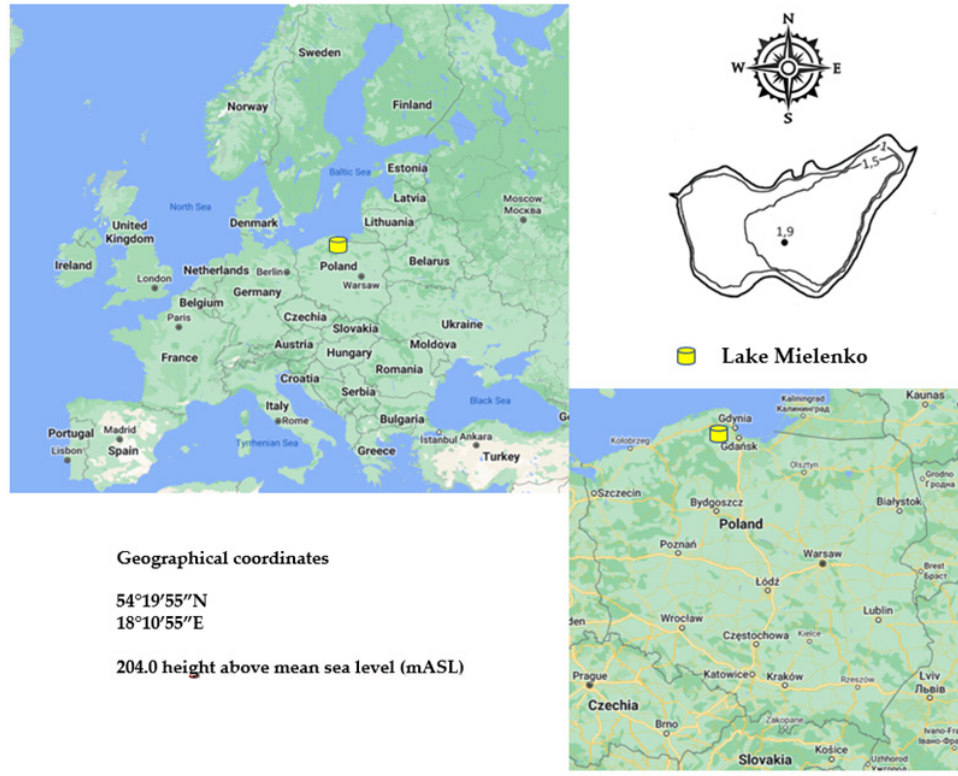
Figure Figure 1. Lake Mielenko’s location in Europe and Poland. Available online: https://www.google.pl/ maps/@52.0666816,18.7171332,6z?hl=en (accessed on 1 July